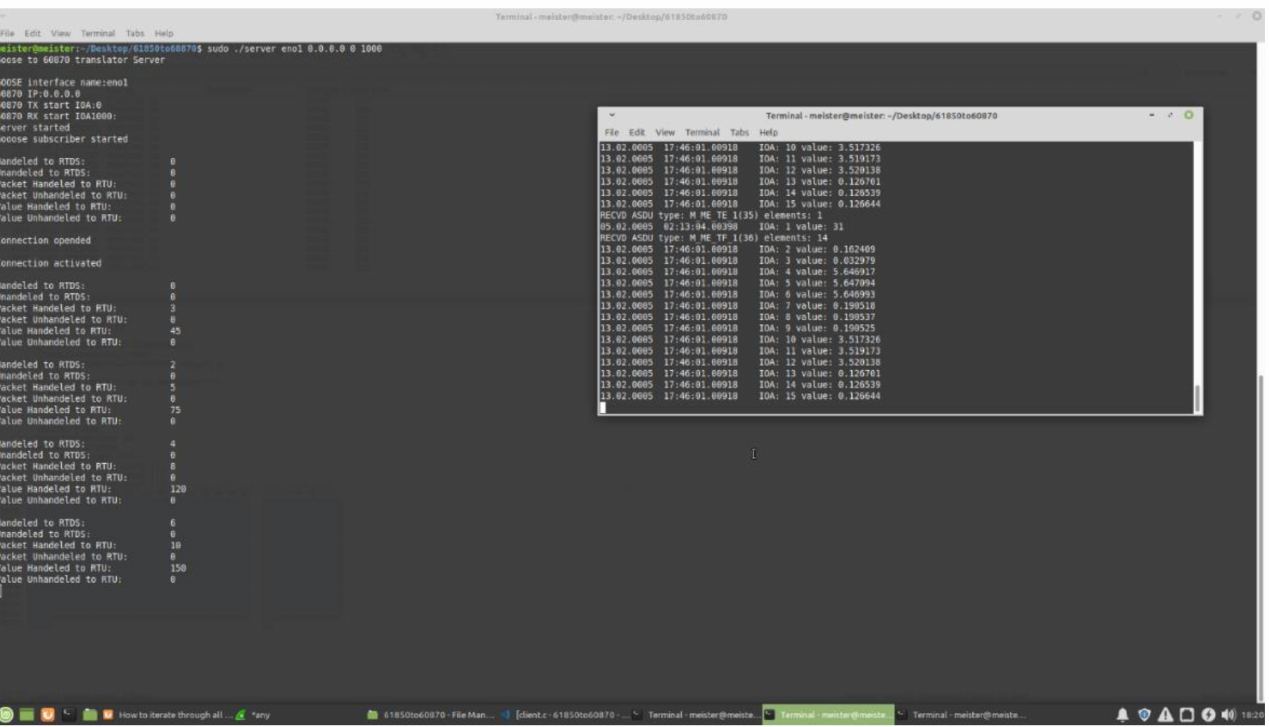
Figure 7. Translator computer desktop.